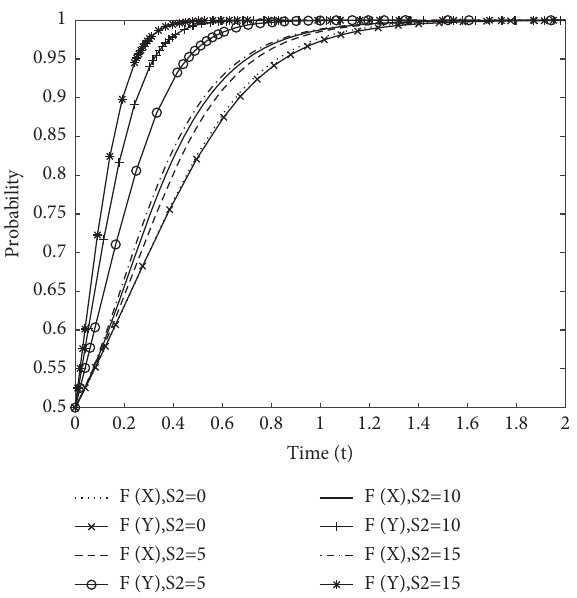
Figure 4: Evolutionary path of S